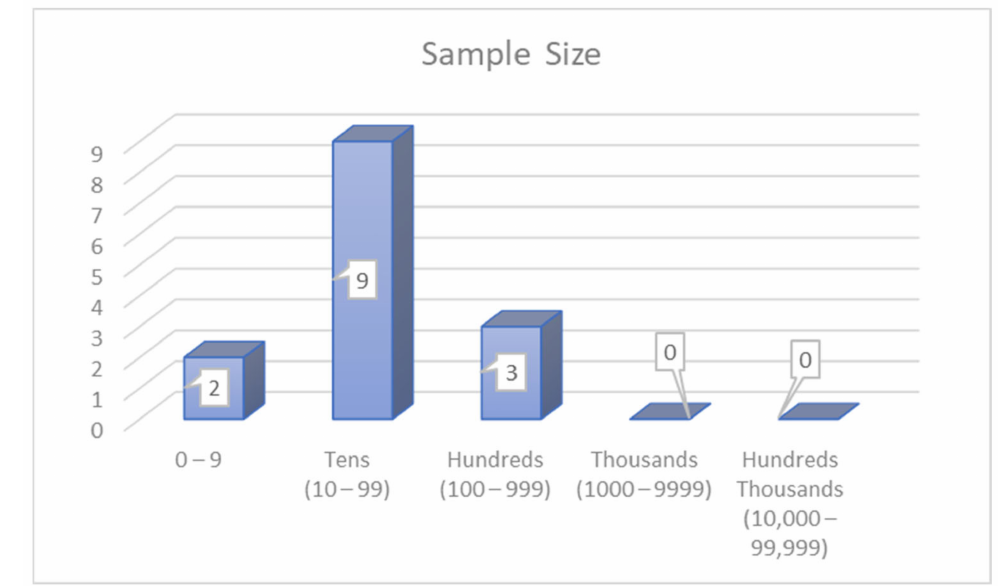
Figure 10. Sample sizes used in studies using simulator